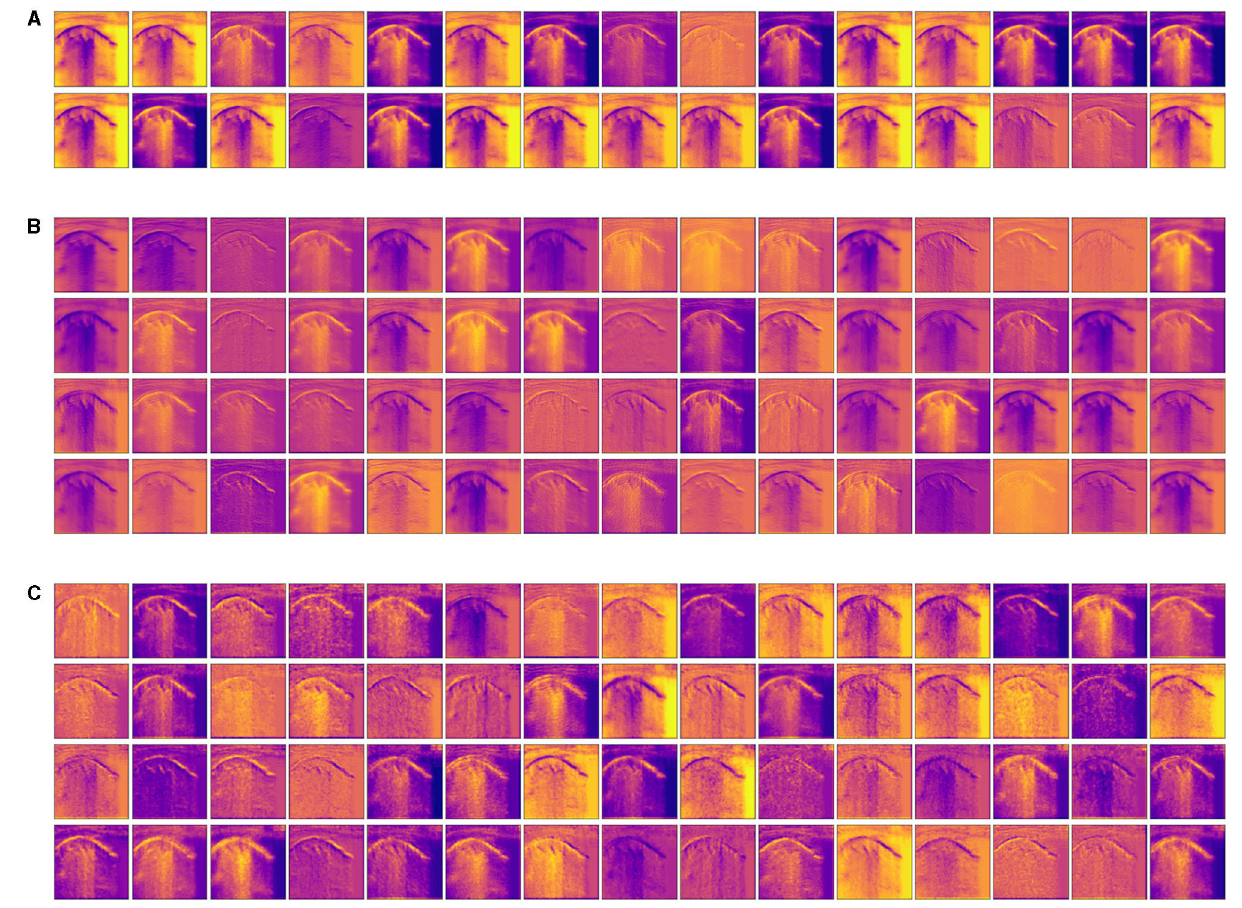
Frontiers in Physiology |